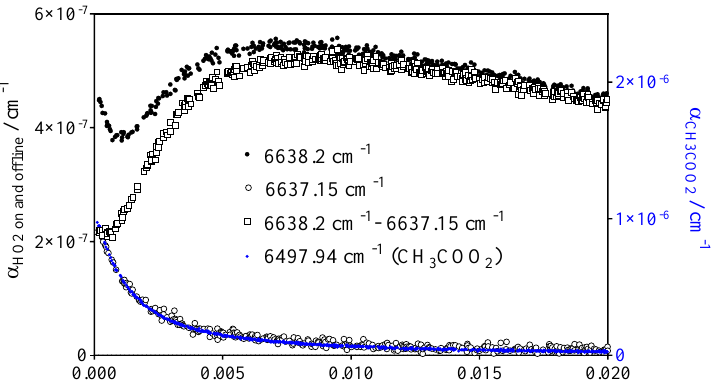
Figure 2. Decays obtained following the 351 nm photolysis of [Cl 2 ] = 4.5 × 10 15 cm − 3 in presence of [CH 3 CHO] = 8.4 × 10 14 cm − 3 at a total pressure of 50 Torr helium ([O 2 ] = 3 × 10 17 cm − 3 ). Black dots: peak absorption of HO 2 • radicals (6638.2 cm − 1 ), open black circles: offline HO 2 • (6637.15 cm − 1 ), open